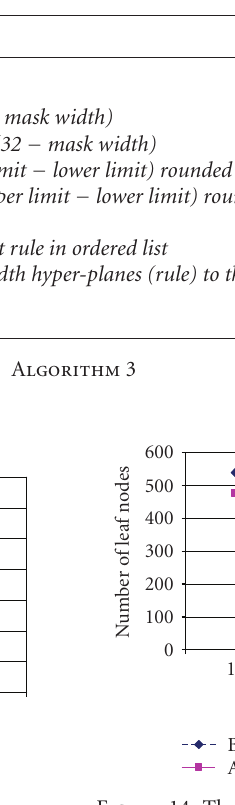
Figure 14: The e ff ect on the number of leaf nodes of moving the largest 10% of the rules.